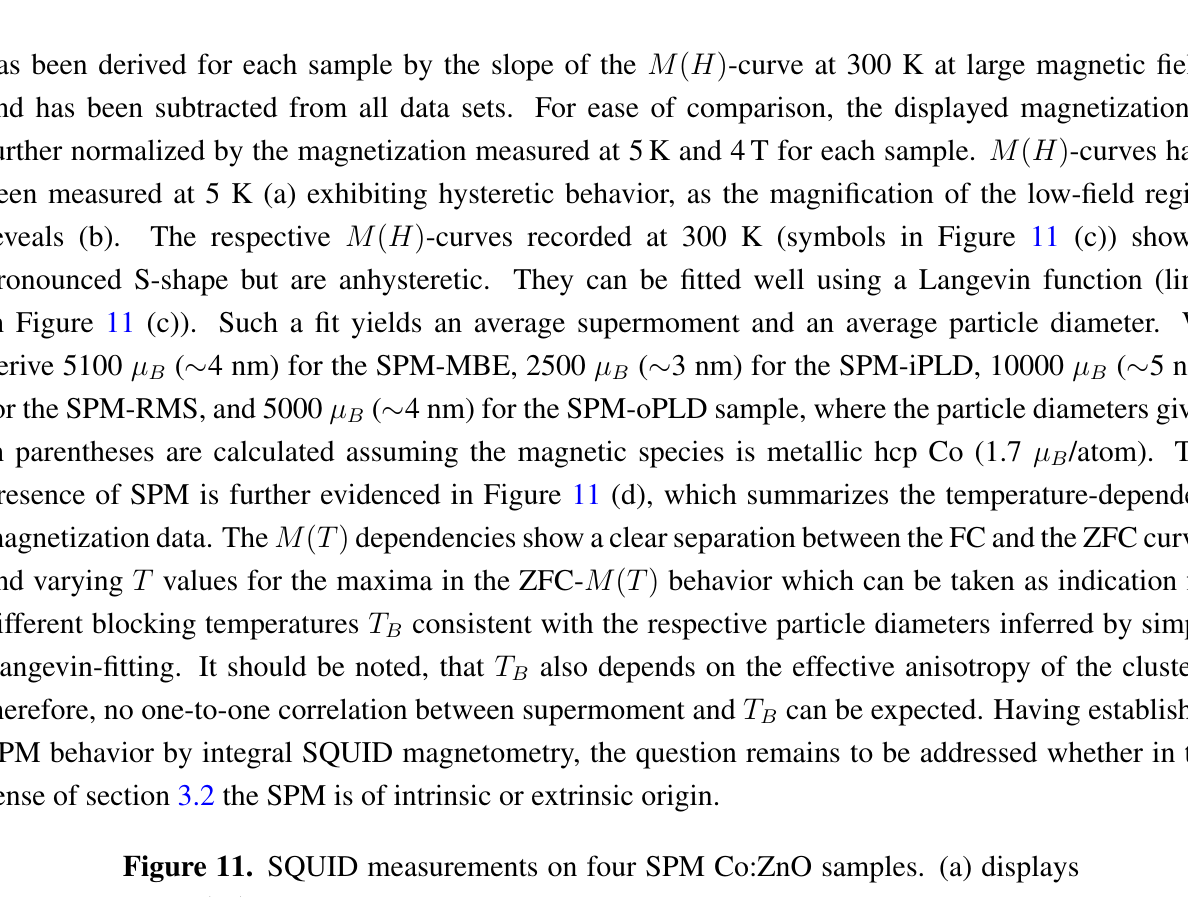
Figure 11. SQUID measurements on four SPM Co:ZnO samples. (a) displays the M ( H ) -curves at 5 K and the low field region is enlarged in (b)